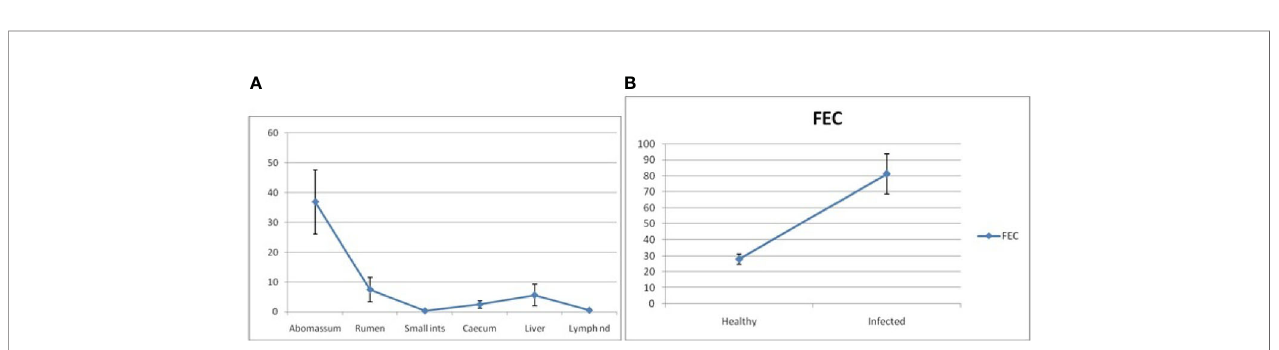
FIGURE 9 | (A) RIG-I expression pro fi ling for different GALT and lymph node in sheep. (B) RIG-I expression pro fi ling for healthy and Haemonchus contortus – infected sheep from abomasum.